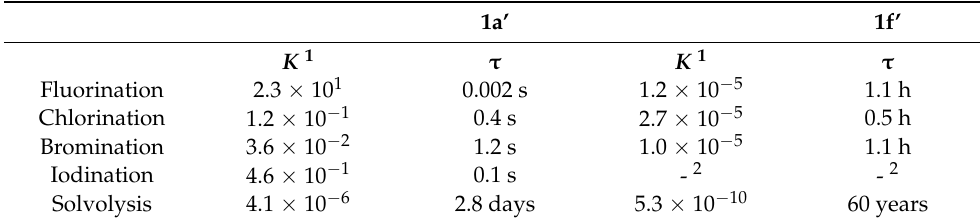
Table 6. Calculated rate constants and lifetimes for the halogenations and solvolysis of 1a’ and 1f’